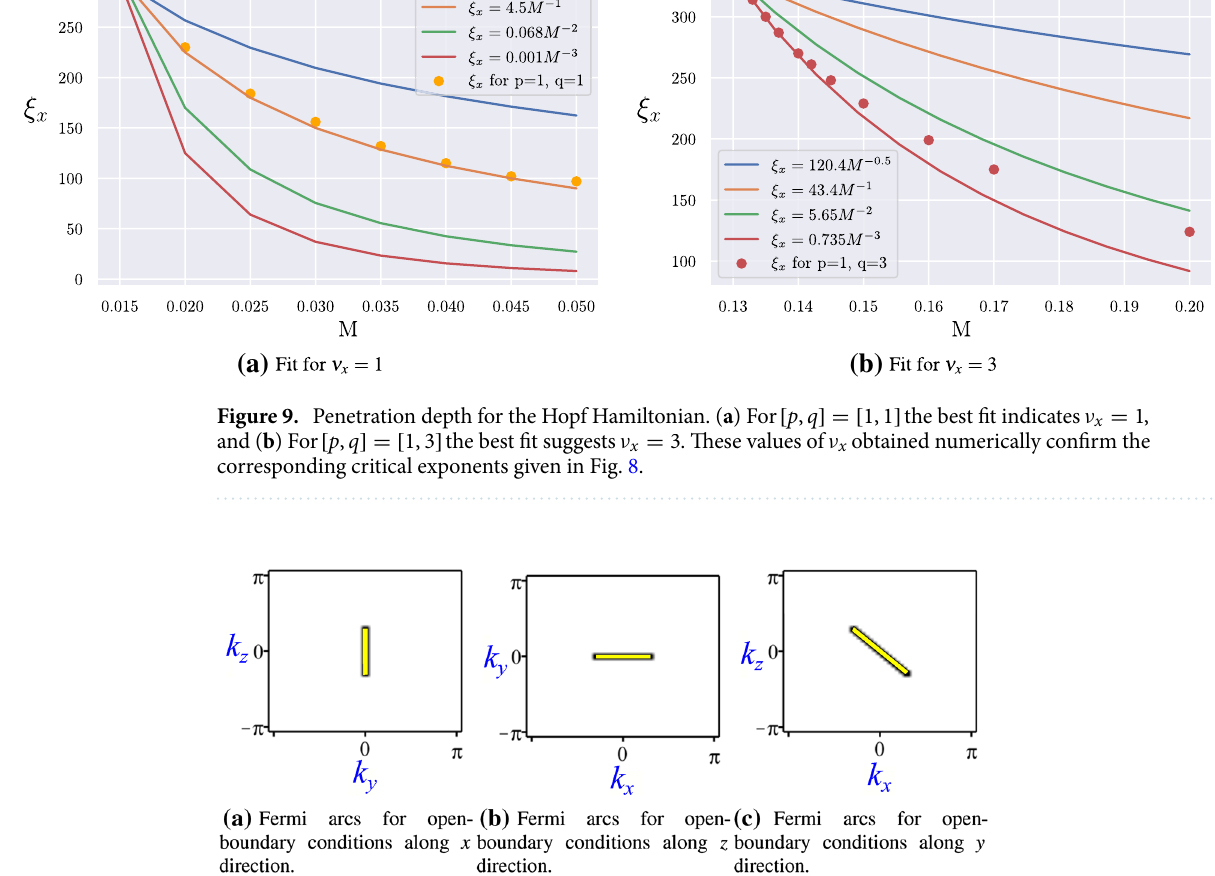
Figure 10. Fermi arcs obtained numerically for the generalized Weyl semimetal model 47